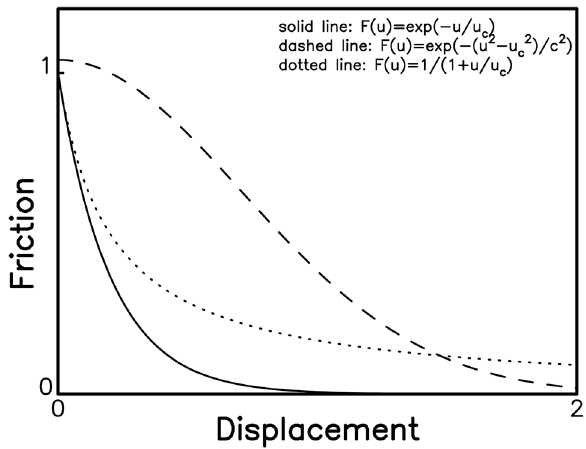
Figure 3. Three slip-weakening friction laws: the solid line for F ( u )= 1/(1+ u / u ) with u = 0.1 m; the dashed line for F ( u )= exp[−( u 2 − u c c with u = 0.1 m and c = 0.3 m; and the dotted line for F ( u )= c ) with u = 0.1 1/(1+ u / u c c